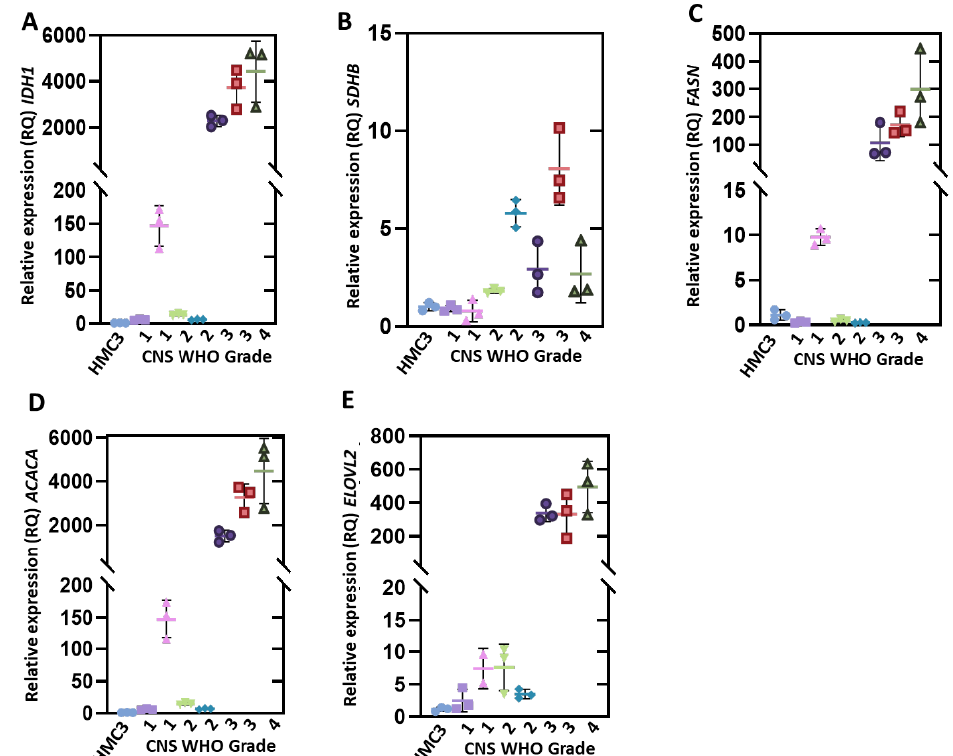
Figure 3. Expression levels of genes that encode enzymes that participate in the essential metabolic pathways of glioma cells. ( A , B ) represent the expression levels of IDH1 A and SDHB genes involved in the Krebs cycle. ( C – E ) represent the expression levels of the FASN , ACACA , and ELOVL2 genes involved in the fatty acid synthesis genes. Relative expression levels were determined using the PKM gene as a reference. Values are means ± SD of quadruplicate determinations. HMC3, CNS WHO 1 (T1), CNS WHO 1 (T12), CNS WHO 2 (T4), CNS WHO 2 (T18), CNS WHO 3 (T7), CNS WHO 3 (T10), CNS WHO 4 (T9).